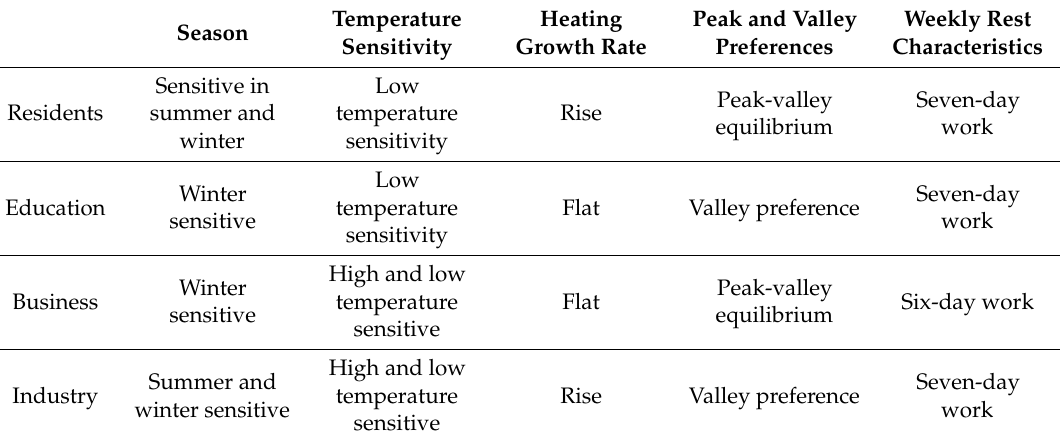
Figure 5. Energy consumption characteristics of the four typical users. Table 2. Four types of customer label